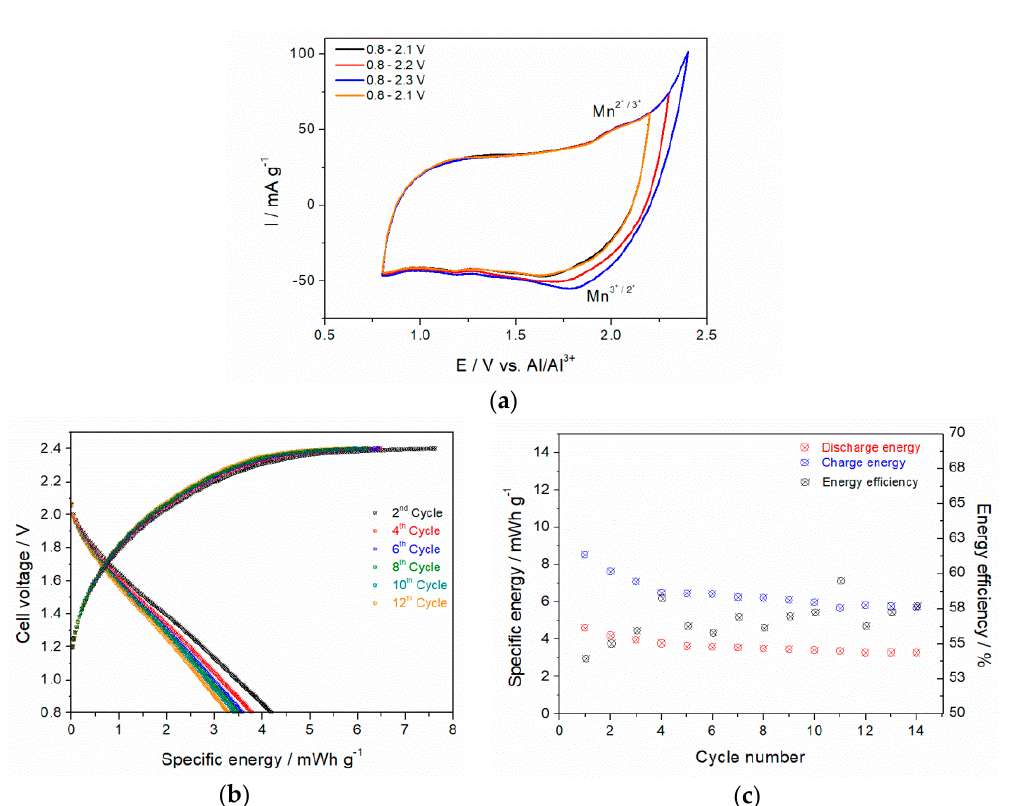
Figure 7. CVs of δ -MnO 2 (14 h @ 110 °C in 1.6 M KOH) with 18 wt% carbon in 1:1.5 EMIMCl/AlCl 3 at 10 mV s − 1 as a function of different potential windows at RT ( a ), galvanostatic charge/discharge behavior of Al-ion cell with an Al foil anode, EMIMCl/AlCl 3 (1:1.5) as electrolyte and δ -MnO 2 cathode at 2.5 mA g − 1 normalized to MnO 2 mass ( b ) and corresponding specific energy and energy efficiency ( c ).